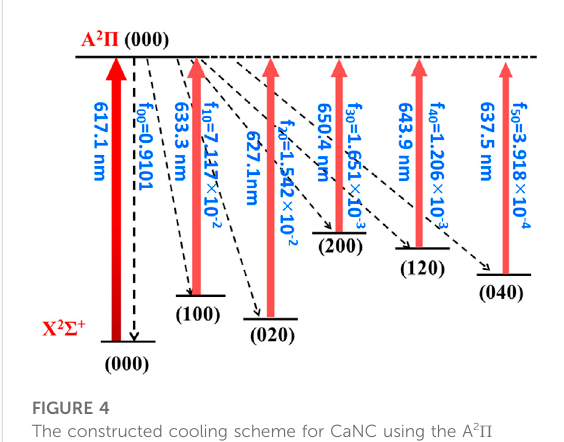
FIGURE 4 The constructed cooling scheme for CaNC using the A 2 Π (000) → X 2 Σ + ( υ 1 υ 2 υ 3 ) transitions. The arrow colors qualitatively representthelaserwavelengthsbydifferentlevelsoftransparency. The rotational branching can be eliminated by driving the J = 1 → J ’ = 0 transition.